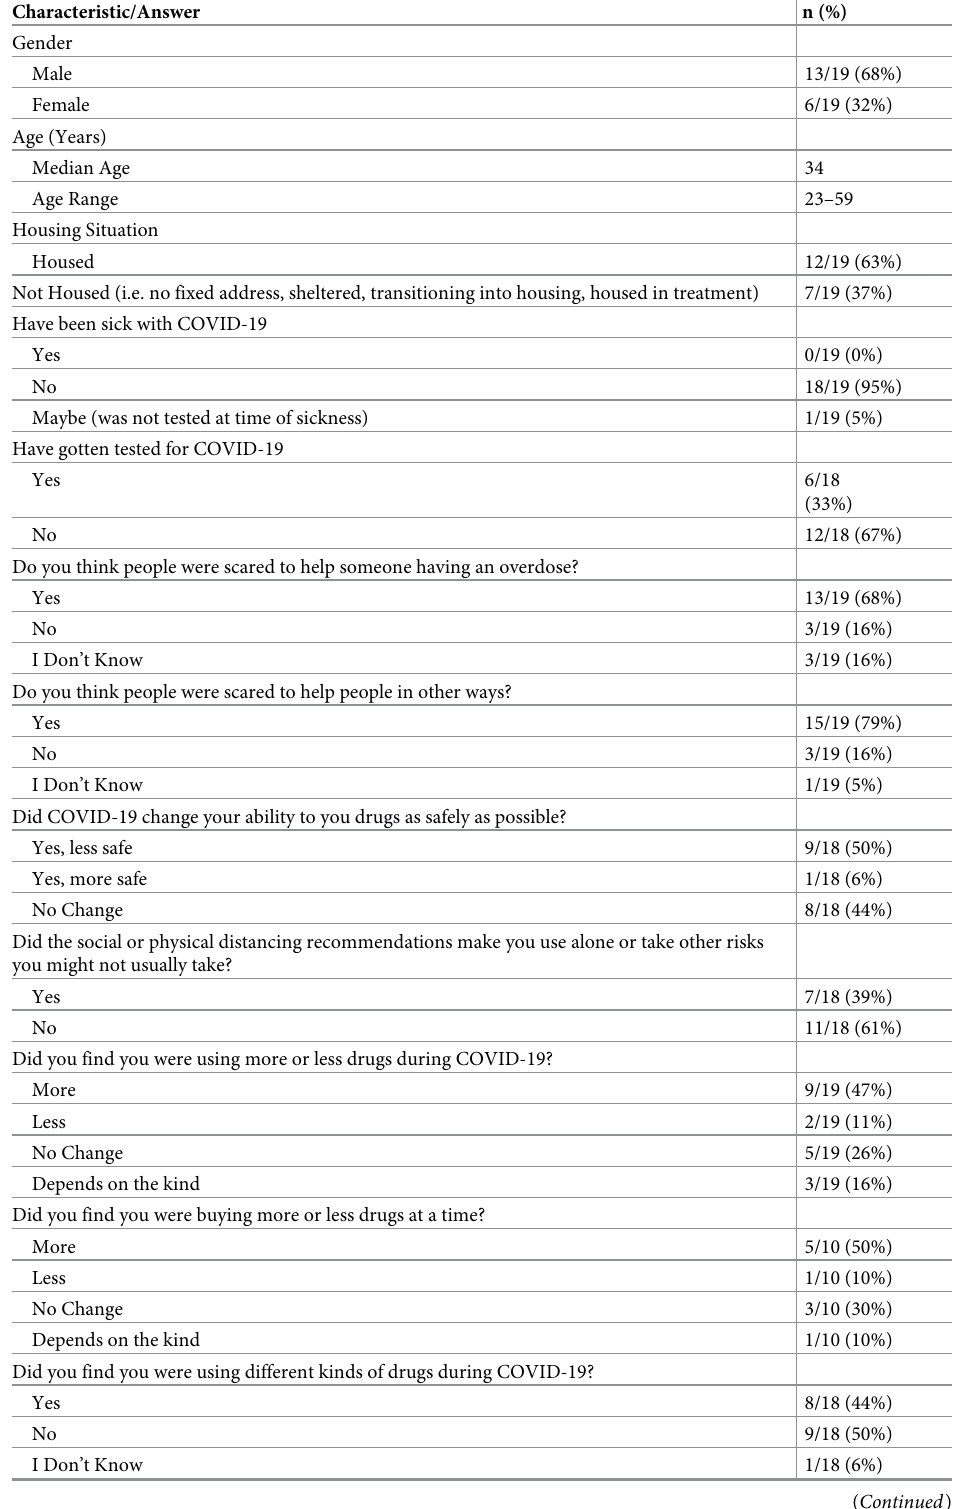
Table 1. Baseline characteristics of participants reported at the time of interview and frequency counts of answers to closed-ended